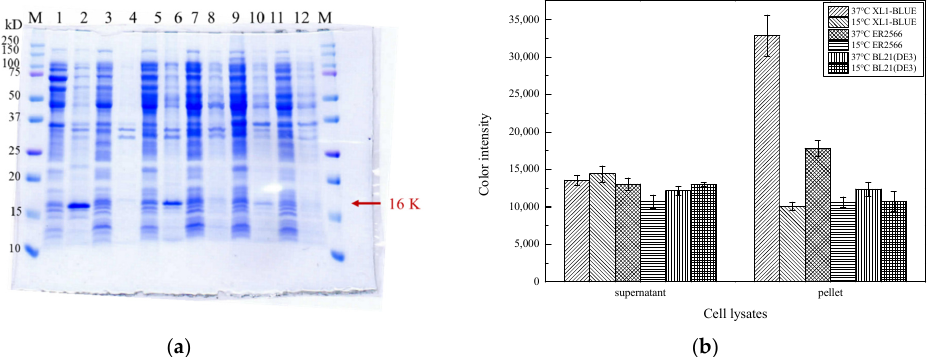
Figure 2. Comparison of different hosts for overexpression of 8 msh . ( a ) SGS-PAGE gel showing the yield of 8 α -MSH fusion protein, where Lane M—marker (kDa); Lane 1–2—supernatant of cell